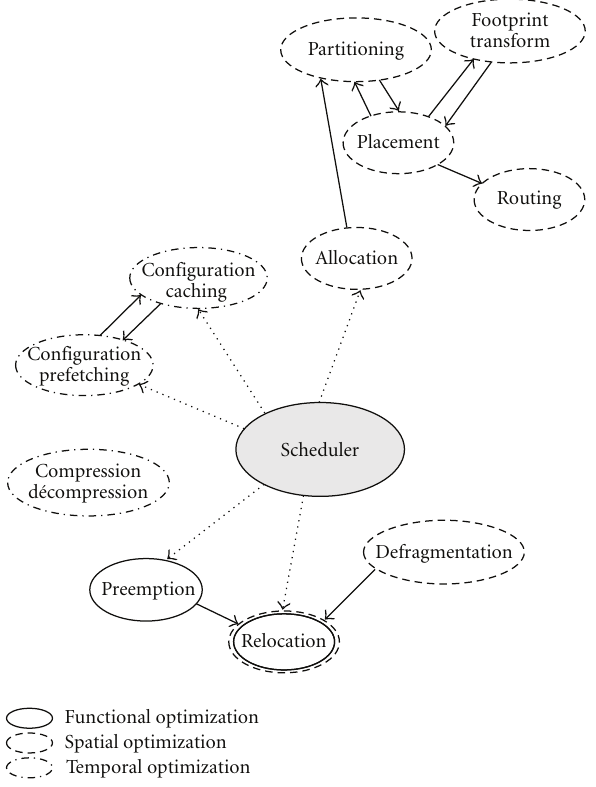
Figure 1: The existing reconfiguration services can be classified into three classes, according to the kind of optimizations they